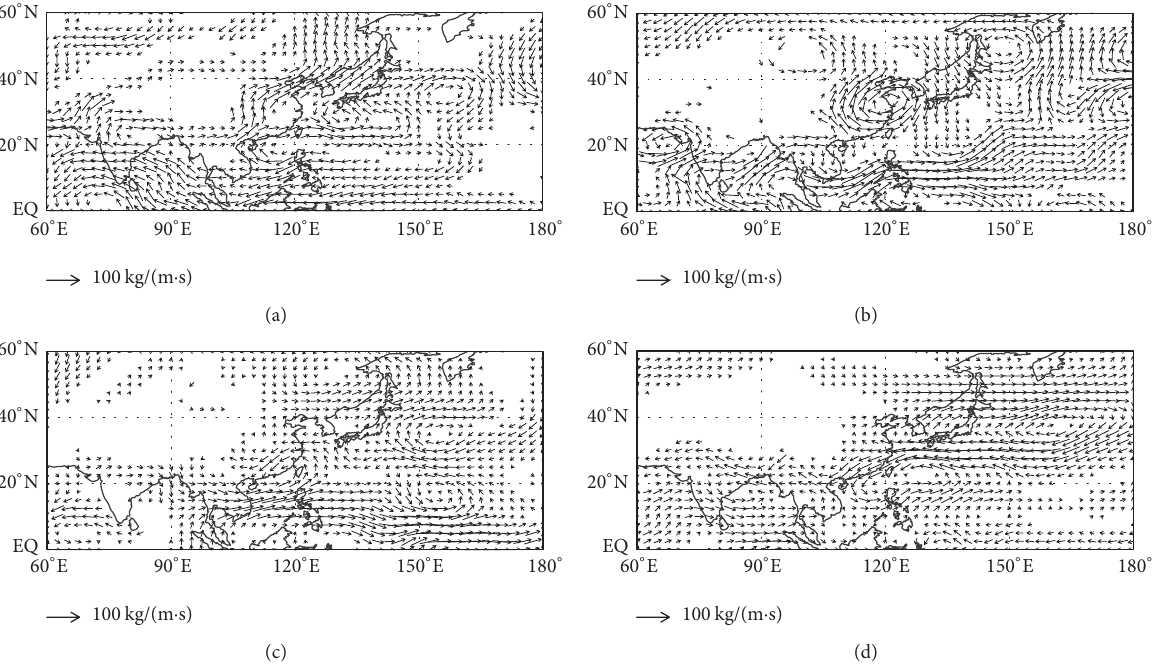
Figure 8: Anomalies of vertically integrated water vapor flux (arrows, units: kg m −1 s −1 ) of the WBWD pattern in the summers of (a) 1966, (b) 1967, (c) 1972, and (d) 1978.